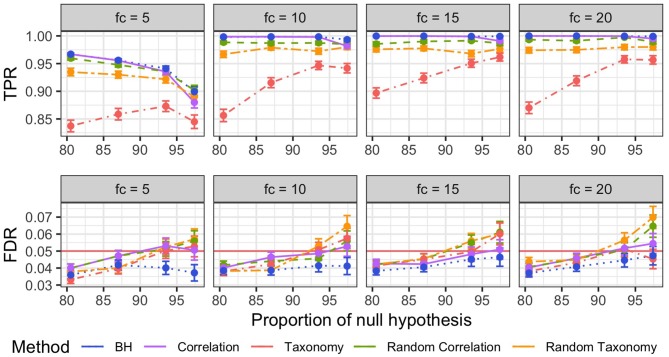
Mean and Squared Error of the Mean (SEM) of the true positive rates TPR (Top) and FDR (Bottom) per different fold changes (facets) for non-parametric simulations. The different FDR control procedures are color-coded. Mean and SEM are computed over 600 replicates.